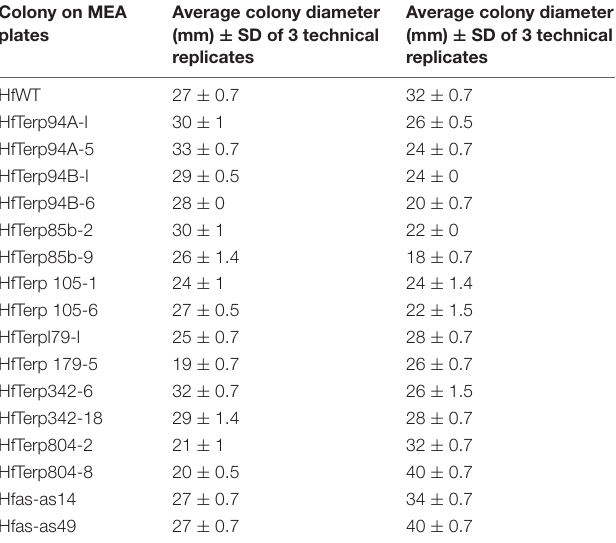
TABLE 2 | Average colony and clearing zone diameters of two selected putative antisense transformants alongside the wild type. Colony on MEA